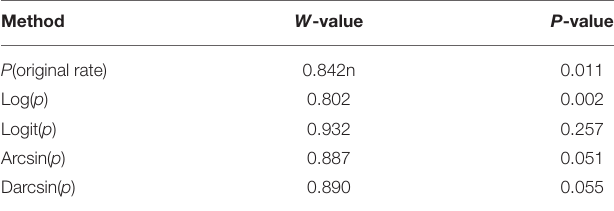
TABLE 3 | The detailed result of Shapiro–Wilk normality test.